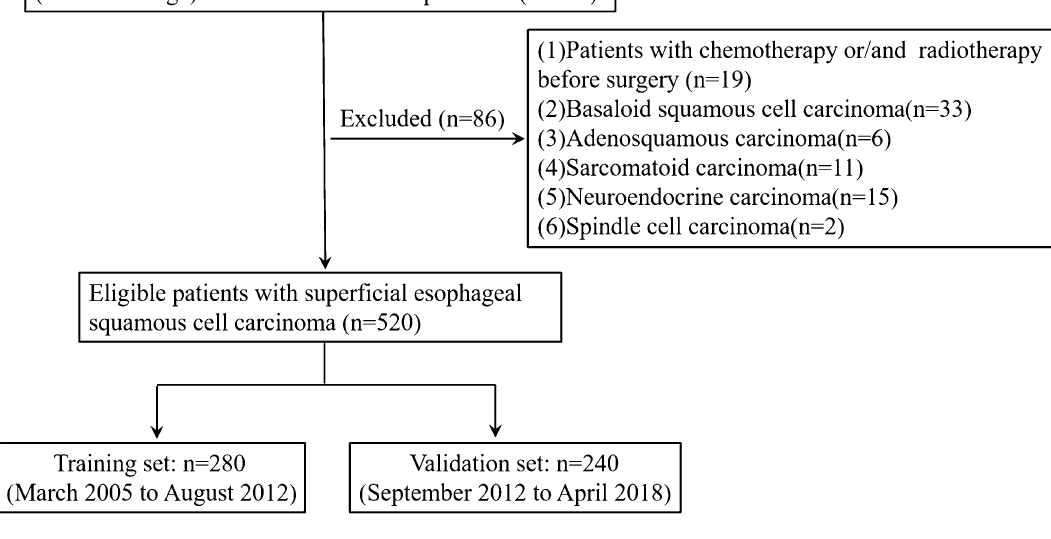
Figure 1. Flowchart of patients included in the